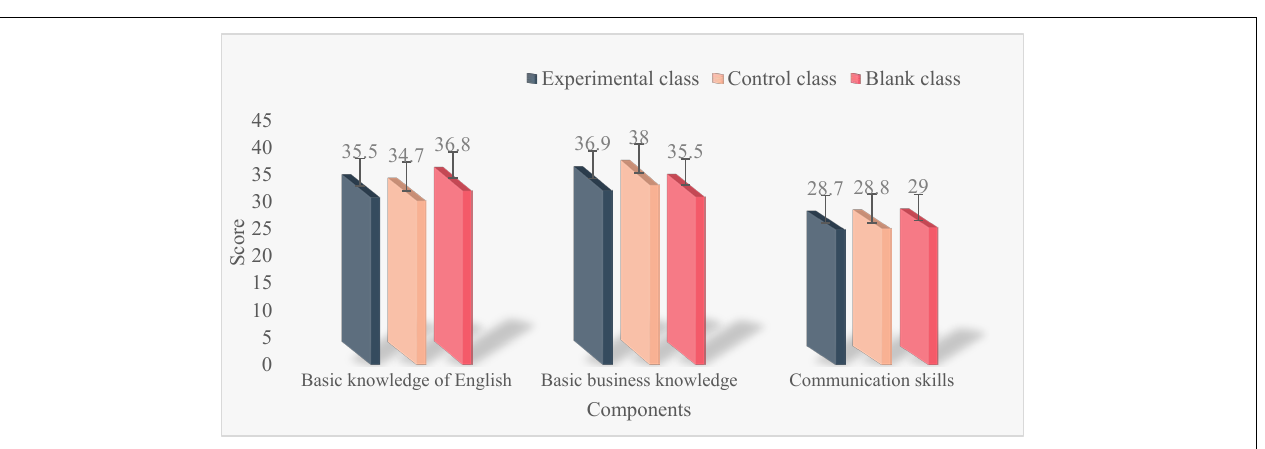
FIGURE 4 | Pretest